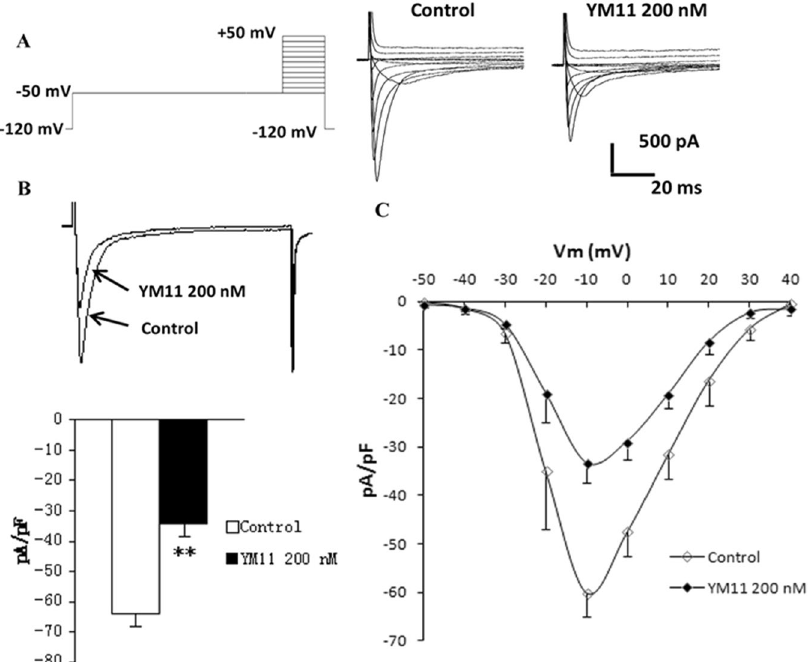
Figure 13. Changes in Na v 1.8 sodium current following YM 11 treatment. The Na v 1.8 current was evoked by a depolarizing voltage steps from − 50 to + 50 mV in 10 mV increments from a holding potential of − 120 mV